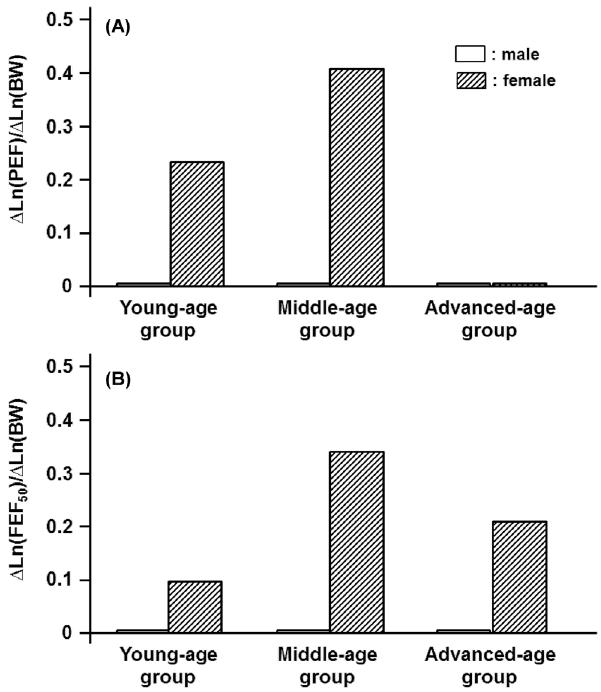
Figure 5. Age-specific impacts of body weight (BW) on PEF and FEF 50 estimated for three different age groups of male and female participants. (A): Partial regression coefficients of Ln(BW) for the reference means of Ln(PEF) in young-, middle-, and advanced-age groups of both genders. Partial regression coefficients of Ln(BW) for Ln(PEF) are defined as D Ln(PEF)/ D Ln(BW). (B): Partial regression coefficients of Ln(BW) for Ln(FEF 50 ) are defined as D Ln(FEF 50 )/ D Ln(BW).